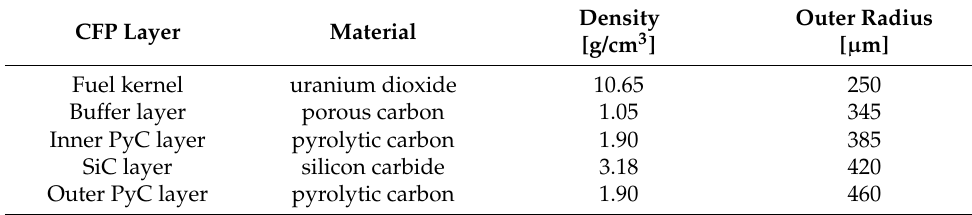
Table 4. Coated fuel particle (CFP)